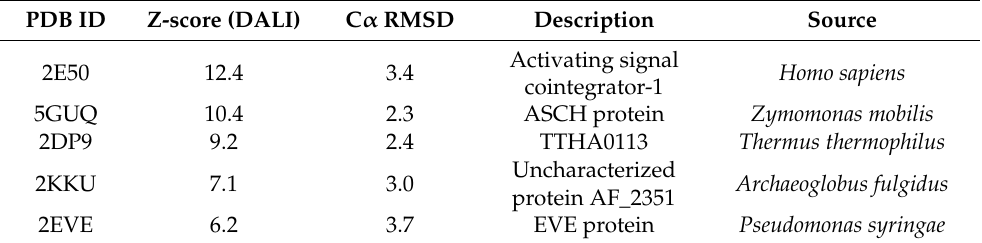
Table 2. Structurally similar proteins to EOLA1 based on the Dali analyses.